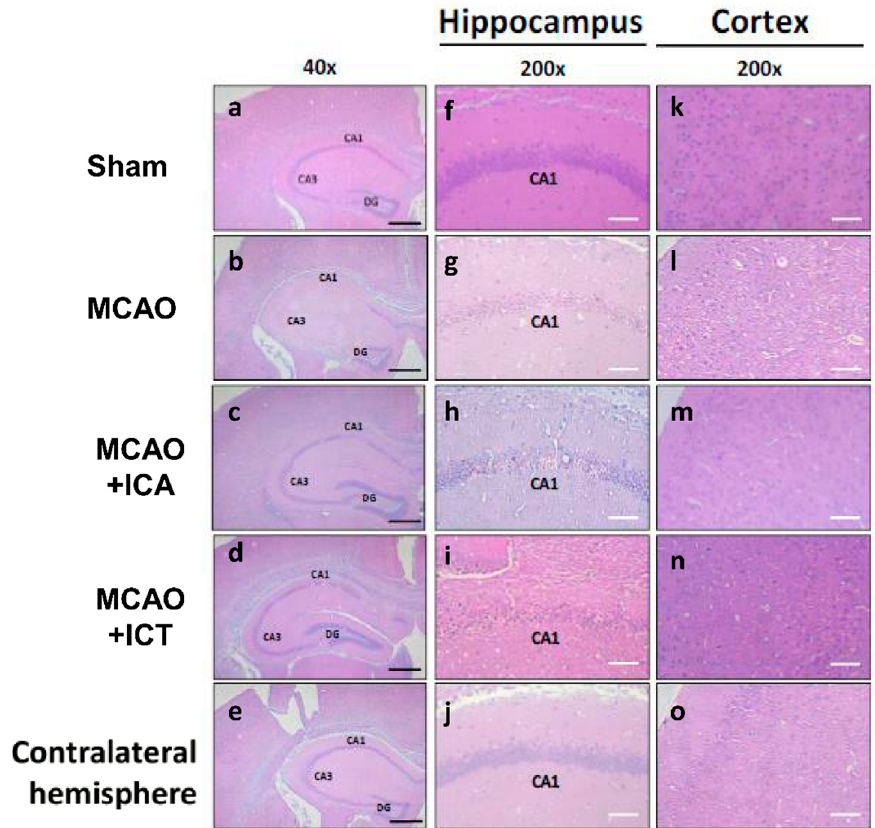
Figure 2. Both ICA and ICT treatment alleviated the histological changes in the left cerebral hemi- sphere of mice with acute cerebral ischemia–reperfusion. H&E staining was used to detect the histological changes of both cortex and hippocampus under 40 × and 200 × magnification. The typical ischemia–reperfusion-injured neuronal cells are demonstrated to be irregularly atrophic and eosinophilic cytoplasm as well as a shrunken nucleus with darkly stained pyknotic nuclei (irreversible condensation of chromatin). Black scale bar = 100 µ m; white scale bar = 500 µ m. Sham ( a , f , k ), MCAO ( b , g , l ), MCAO + ICA ( c , h , m ), MCAO + ICT ( d , i , n ), and contralateral hemisphere ( e , j , o ) are shown. The results are representative from at least four independent experiments.